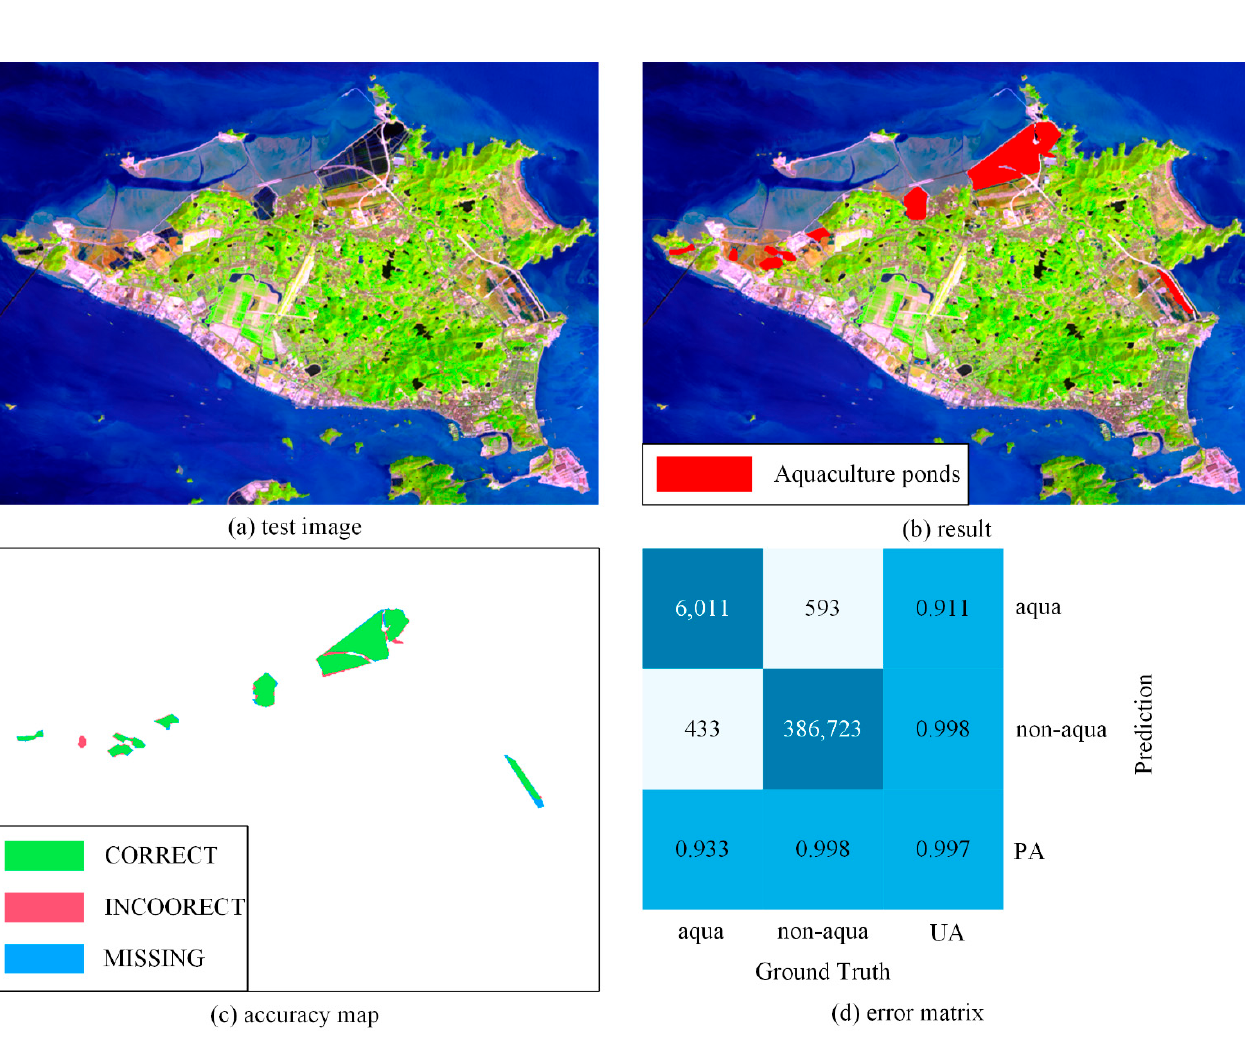
Figure 9. The extraction results of Daishan Island: ( a ) original image, ( b ) extraction result, ( c ) accuracy map, ( d ) error matrix. Table 3. Accuracy evaluation of coastal aquaculture ponds extraction in Daishan Island, China.